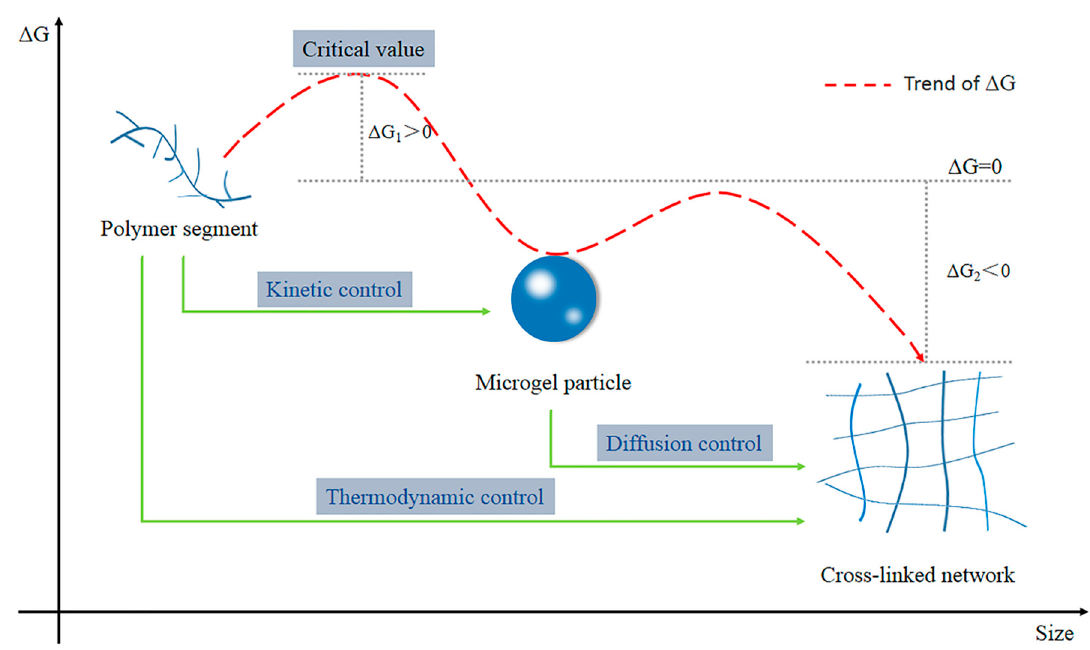
Figure 7. Schematic illustration of free energy changes with size in the gel particle formation and growth stages. Under thermodynamic control, the final structures are in the state of minimum free energy. If kinetic control intervenes, the structure can be trapped in a metastable state (gel).